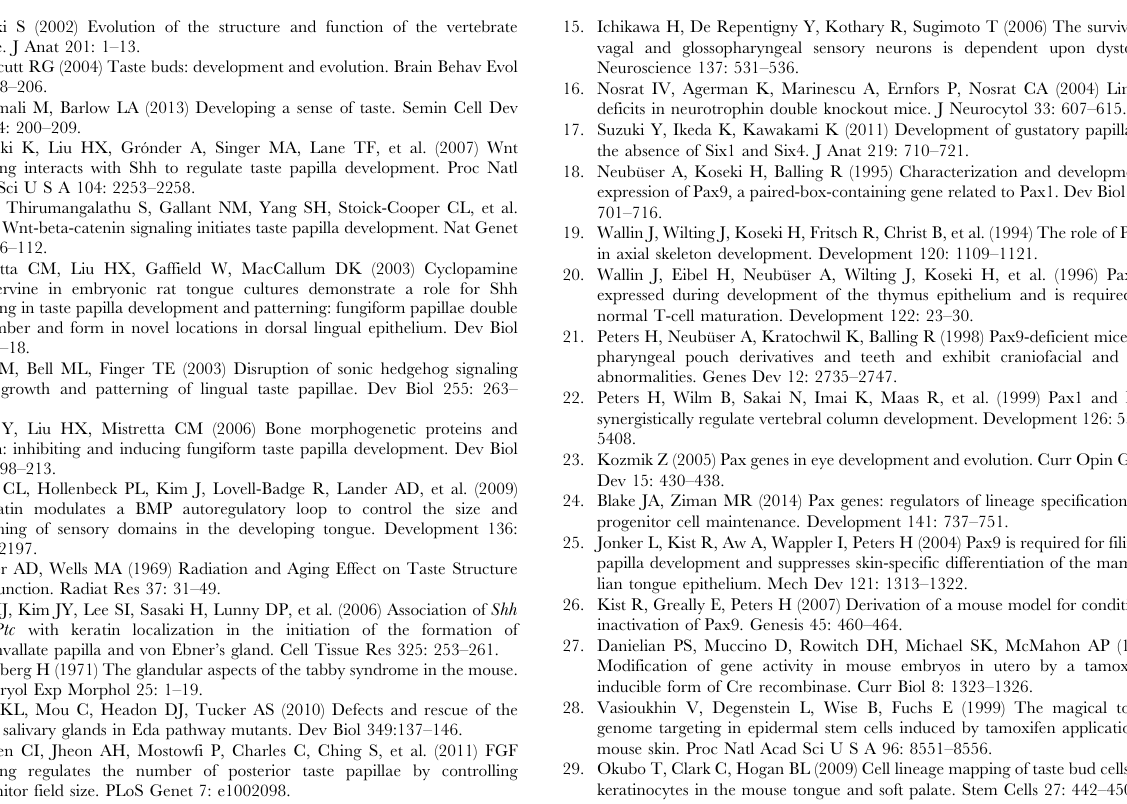
with BSA. (C) The CVP of wild type explants treated with purmorphamine (PUR) did not form an enlarged CVP dome after culture. Scale bars: 100 m m. (TIF) Figure S8 (A) Pax1 is expressed in taste bud cells of the adult FOP. In contrast, epithelial cells of the developing (B) and adult (C) FUP located on the dorsal tongue do not express Pax1. Scale bars: 50 m m. (TIF) Table S1 Measurements of CVP trenches in controland Pax1 2 / 2 embryos at E18.5. The lengths of epithelial trenches is significantly reduced in Pax1 2 / 2 embryos, whereas the width is not, the latter ruling out a general growth defect of the posterior tongue region of Pax1 2 / 2 embryos at this developmental stage.